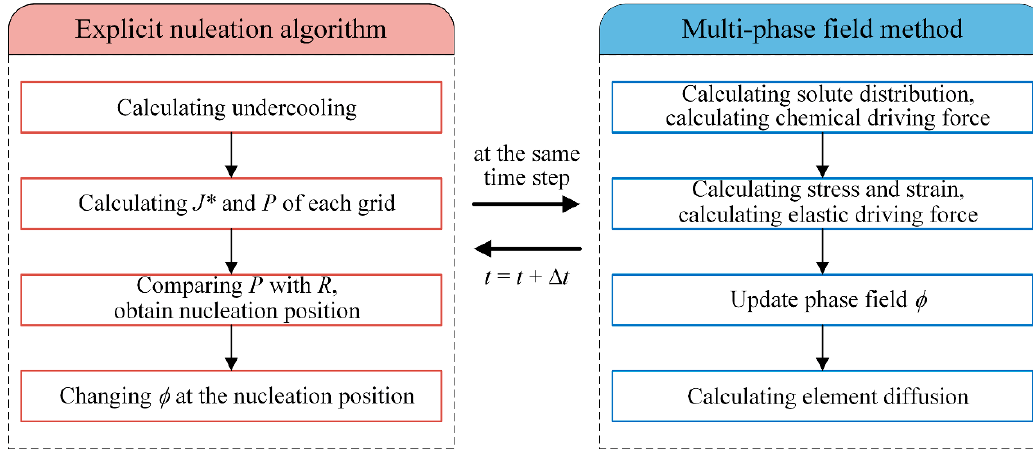
Figure 2. Calculation flow chart.